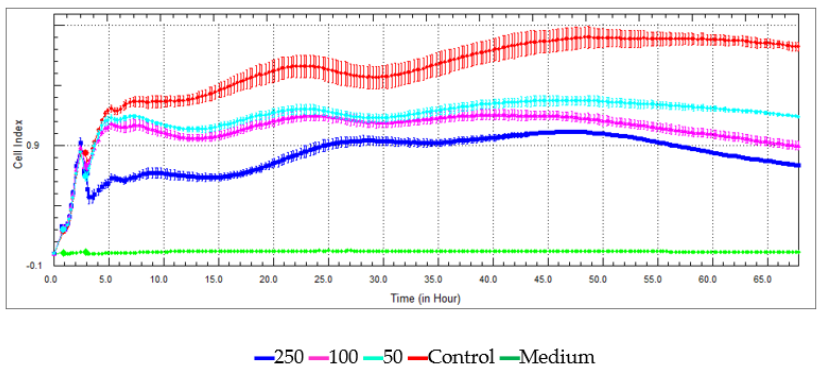
Figure 8. Antiproliferative activity against the Hela cell lines of n -butanol extract.